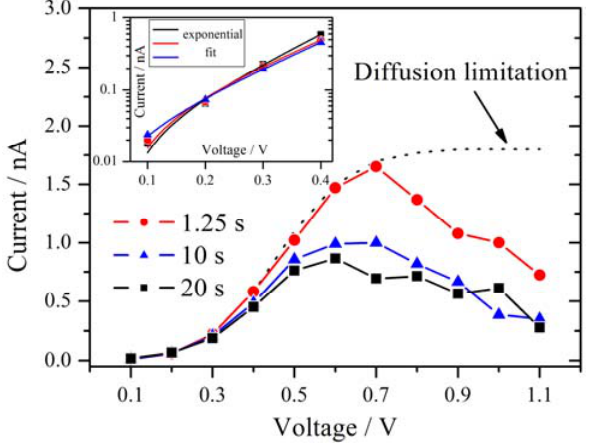
Figure 5. Current-voltage polarization curves derived at three different times after the beginning of the measurement as indicated in Figure 4. A maximum is observed near 0.6 V–0.7 V. The typical diffusion limitation is indicated by the dashed line. The inset shows a Tafel plot of the overpotential region <0.5 V with the corresponding exponential fits.